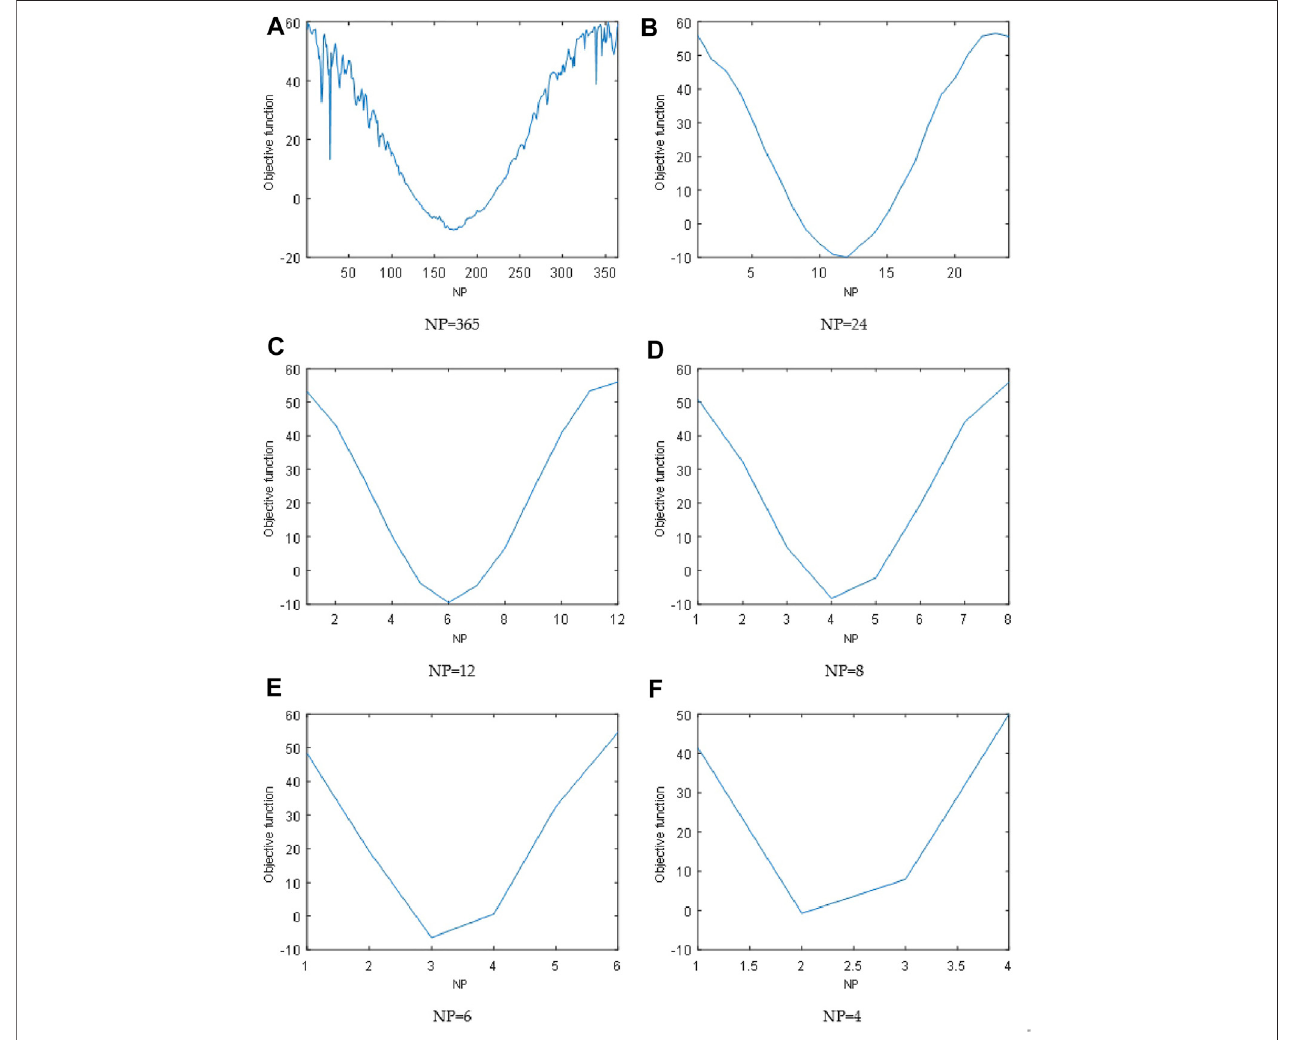
FIGURE 2 | Optimum tilt angle estimates for various NPs for Yanbu using model